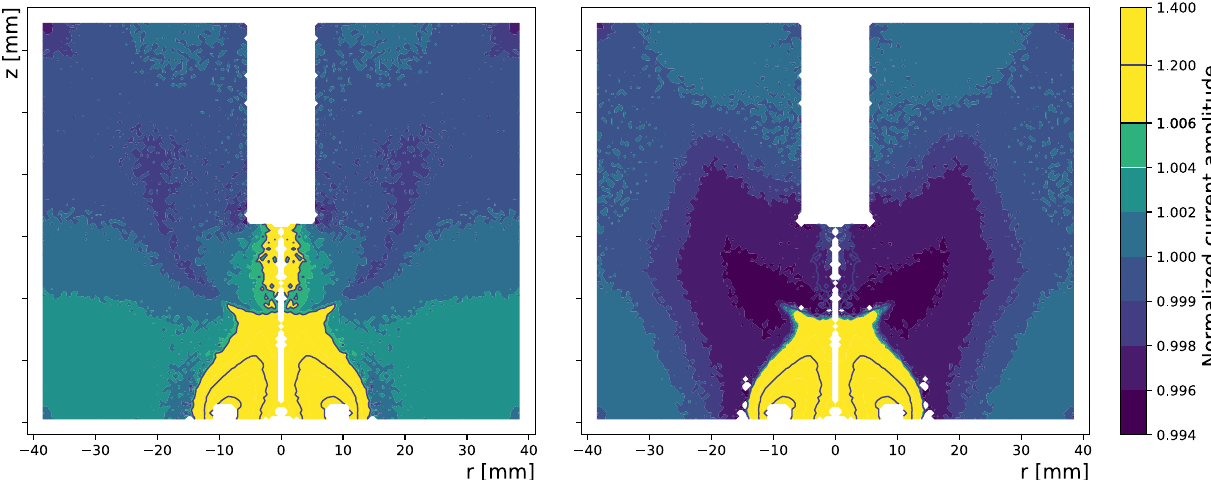
( a ) DEP events from data (filled colored contour) and simu- lations (gray contour lines) Fig. 5 Distribution of the A / E and rise time for a DEP events and b 0 νββ events. The distributions are shown for experimental data (color maps) and simulated data (contour